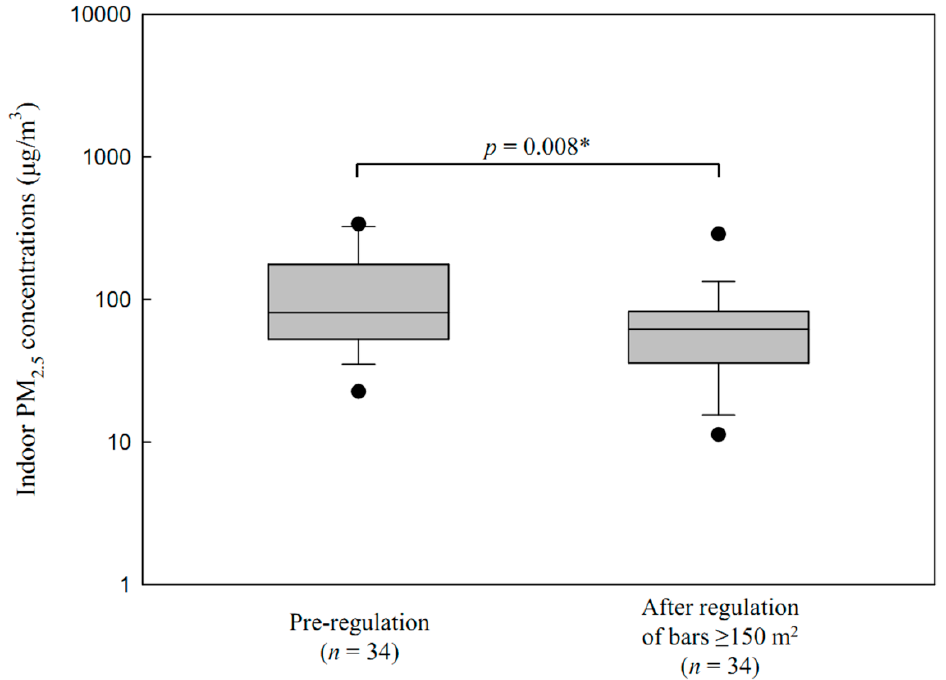
Figure 1. Distribution of indoor PM 2.5 concentrations in Seoul bars, pre-regulation, ≥ 150 m 2 , and after the regulation of bars ≥ 150 m 2 . * Student’s t -test. Int. J. Environ. Res. Public Health 2016 , 13 , x